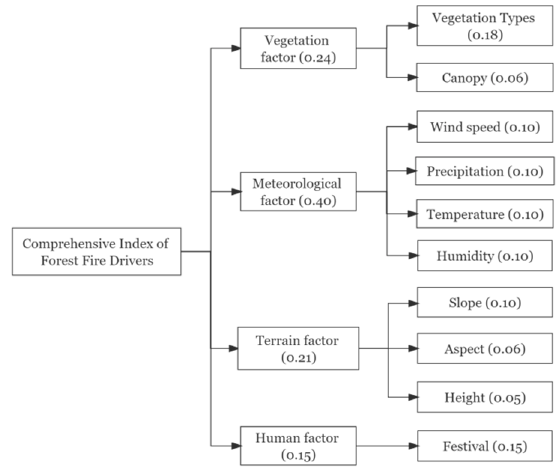
Figure 15. Forest fire risk factor indicator